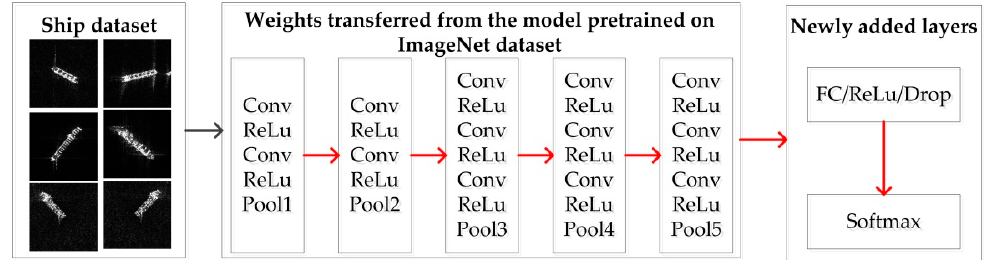
Figure 6. Workflow of training using transfer learning on the ship dataset for ship classification based on VGG16. The red arrows indicate that the weights involved in these layers will be learned, and the green arrows represent that the parameters will remain unchanged.